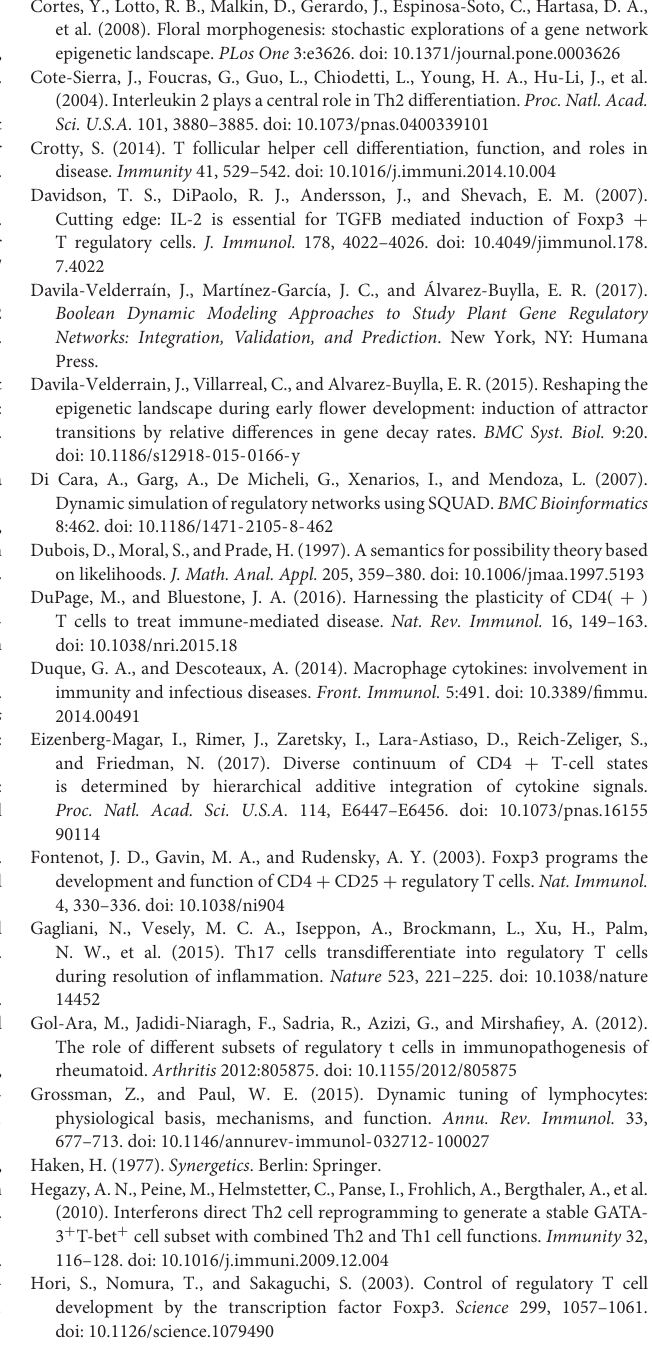
FIGURE S1 | Sensitivity analysis of the parameter b . Effect of various values of b (5, 10, 25, and 50) in abrupt (IL2e), gradual (IL10e), and mixed (IL6e + IL21e + TGFBe) transitions. The model predictions do not depend upon the specific choice of b if this parameter is large enough ( b ≥ 10). DATA SHEET S1 | References of the CD4 + T cell regulatory network. DATA SHEET S2 | Boolean rules of the CD4 + T cell regulatory network. DATA SHEET S3 | Boolean attractors of the CD4 + T cell regulatory network.